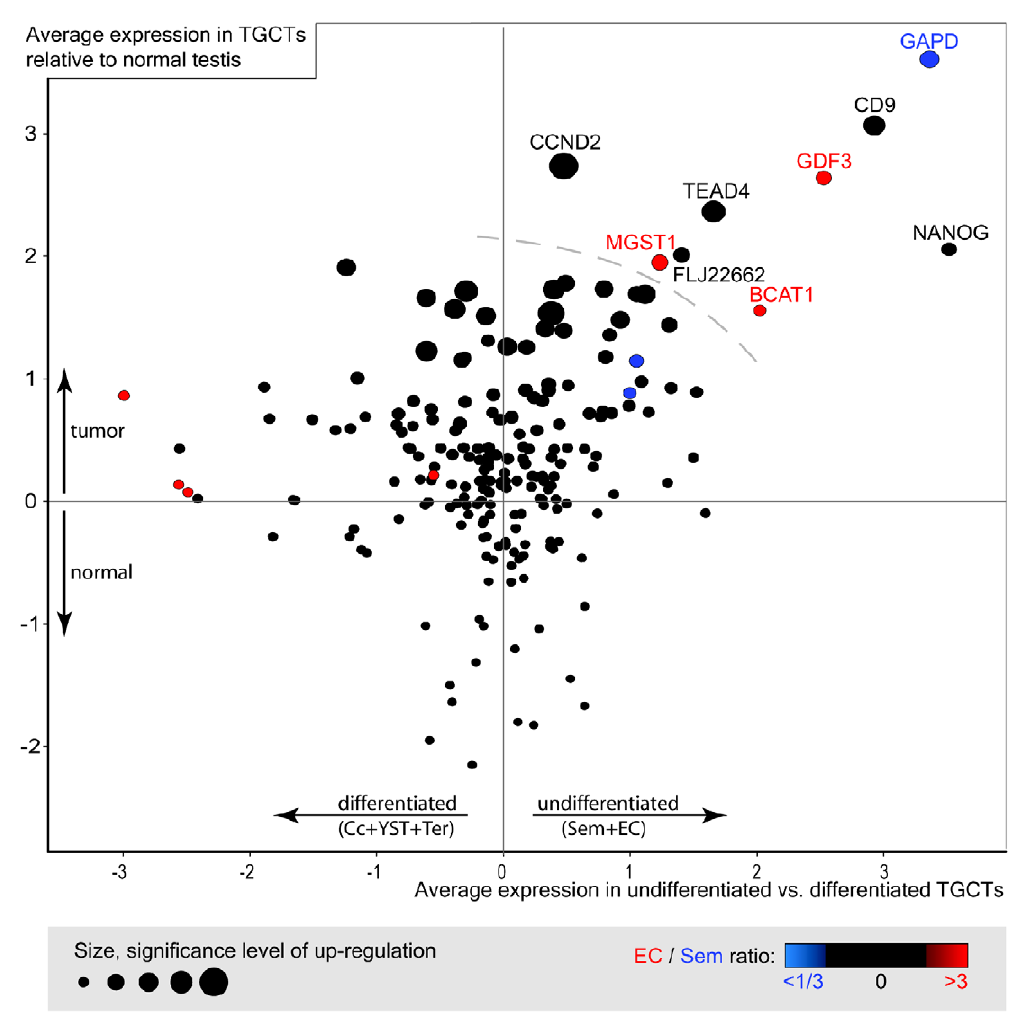
Fig. 2. Over-expression of genes located on chromosome arm 12p. Genes located in the upper part of the chart have higher expression in TGCTs than in normal testicular tissues. The significance of the association is implicated by the size of the circles (the bigger the circle, the more significant the association). Genes in the right part of the figure have a higher expression in undifferentiated stem cell-like histological subtypes (seminomas and embryonal carcinomas) than in more differentiated types (choriocarcinoma, yolk sac tumor, and teratoma). Our hypothesis is that the genes in the upper-right corner are likely to be target “driving genes” of the 12p-amplifications of